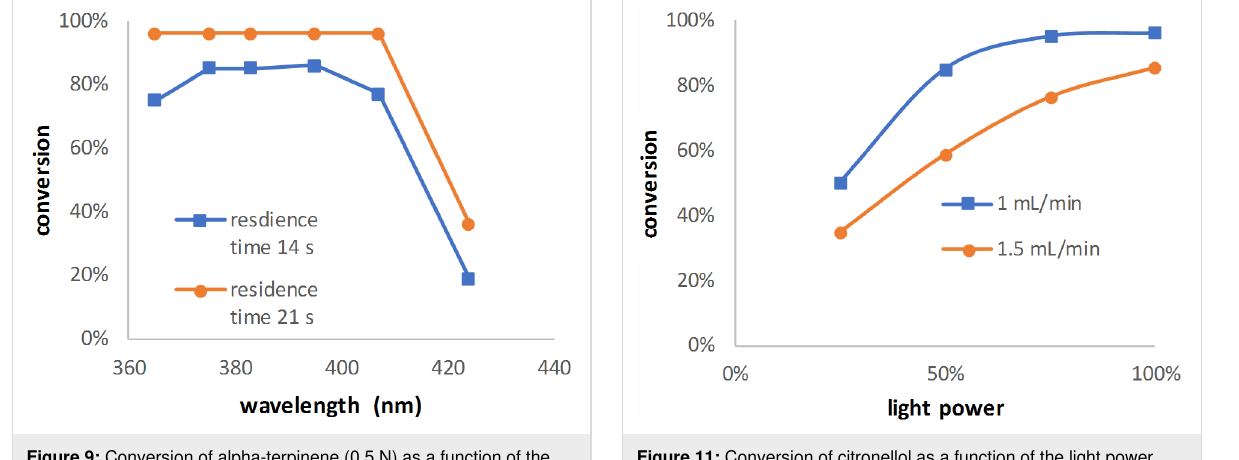
tion of the light power arose. The answer to this can be found in Figure 11: rather large changes in the conversion of citronellol were observed as a function of the light power, and a greater effect was unsurprisingly observed for the slower flow rate.